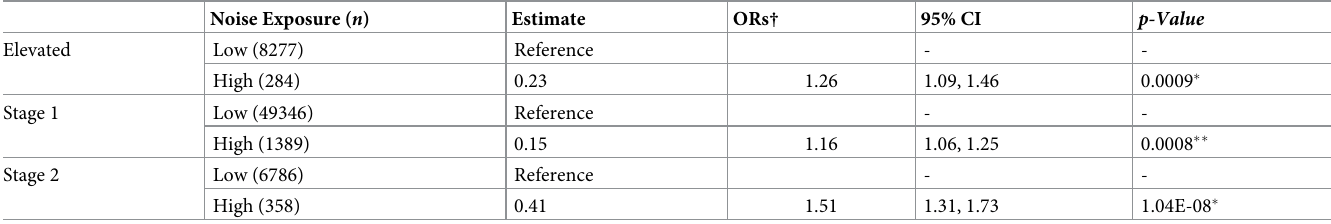
Table 5. Logistic model for associations between noise exposure and hypertension.